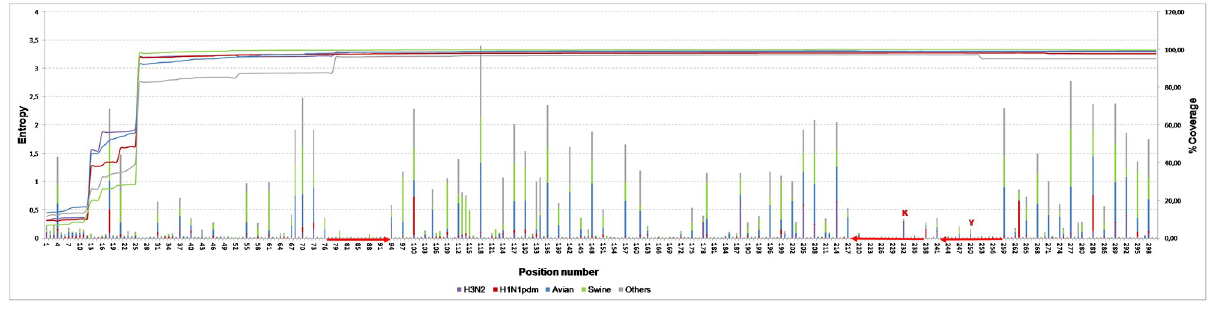
Fig 1. The entropy